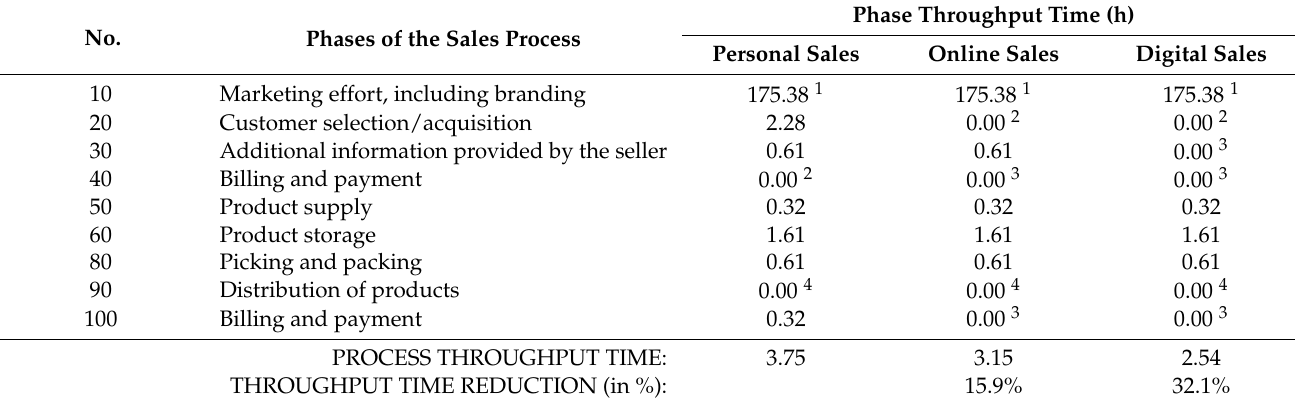
Table 10. Process throughput time of the sales